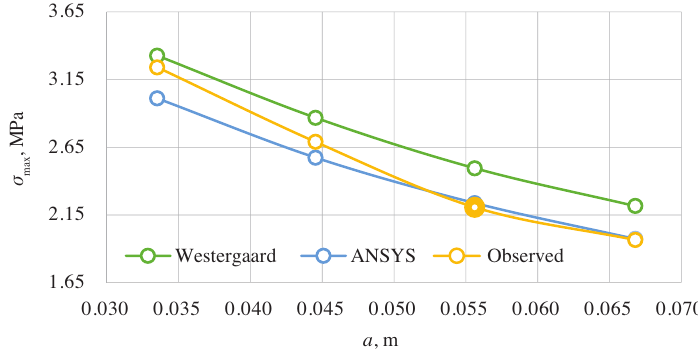
Figure 9. Variation of load area radius ( h = 3.38 cm and load at the center)